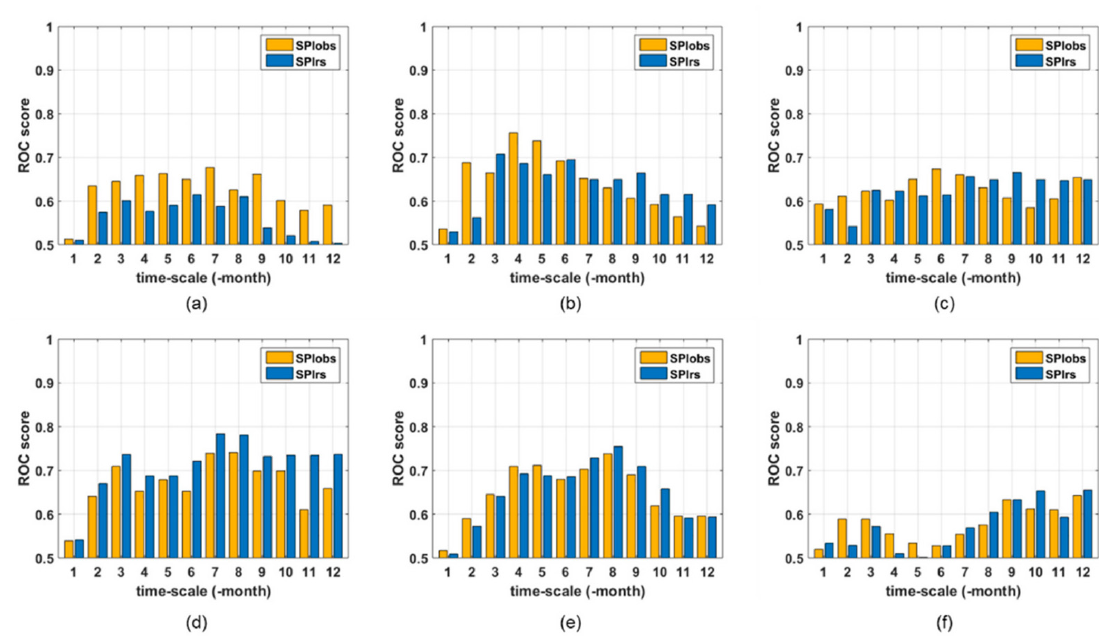
Figure 4. ROC scores of SPI at ( a ) Chungcheong, ( b ) Gangwon, ( c ) Gyeongbuk, ( d ) Gyeongnam, ( e ) Gyeonggi and ( f ) Jeolla. The horizontal axis is the time scale of the drought index, and the vertical axis is the ROC scores of the SPI calculated at each time